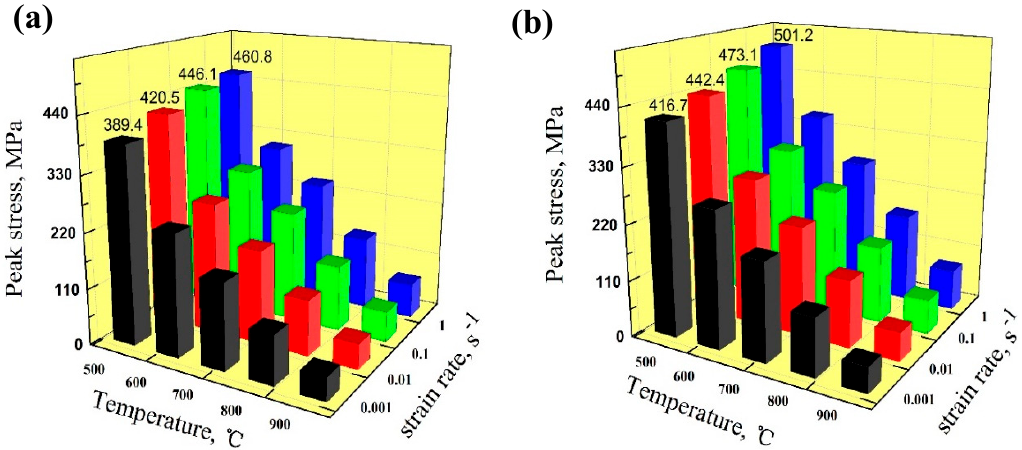
Figure 9. The peak stress at different temperatures and strain rates: ( a ) Cu-Ni-Co-Si-Cr alloy; ( b ) Cu-Ni-Co-Si-Cr-Ce alloy.